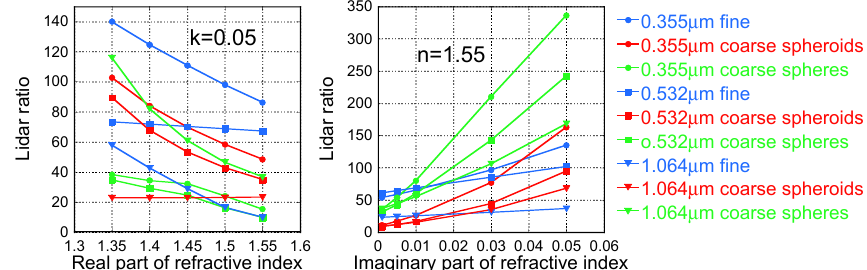
Fig. 10. Dependence of lidar ratio of fine and coarse modes on complex refractive index and particle shape.